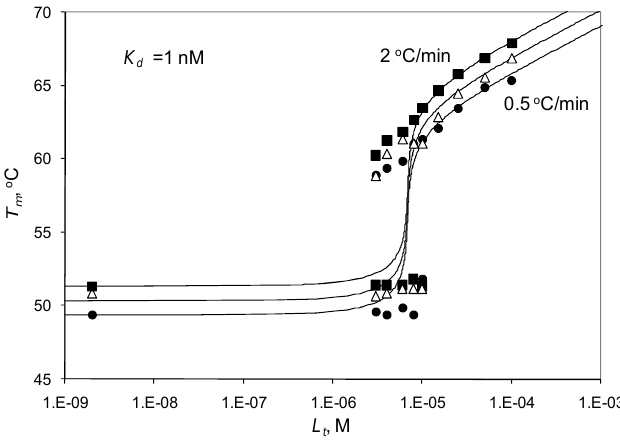
Figure 5. The dependence of Hsp90 α N melting temperature on radicicol concentration with various rates of heating. Data points show the melting temperatures of ligand-bound and free components at three heating rates: (cid:132) - 2 ºC/min, Δ - 1 ºC/min, and (cid:122) - 0.5 ºC/min. Lines are drawn according to Equation (12). Note that the T obtained at different heating rates yield the same binding